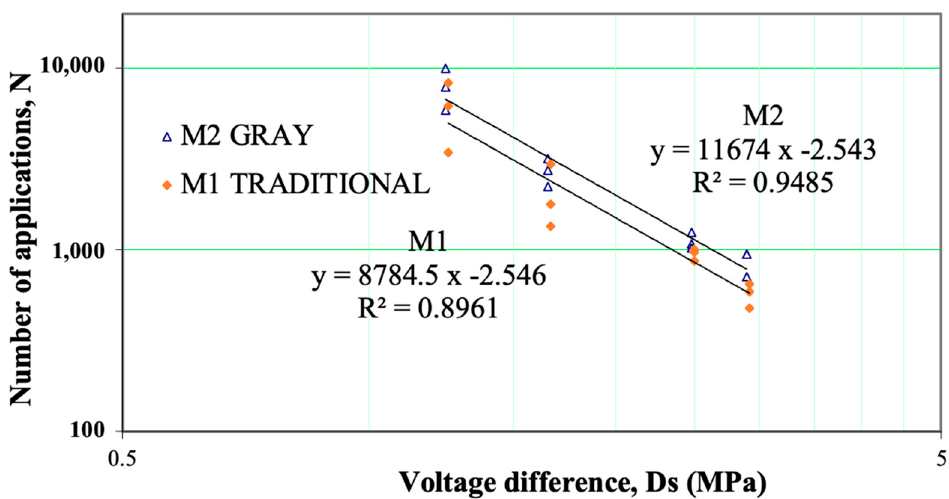
Figure 8. Fatigue life x Voltage difference.